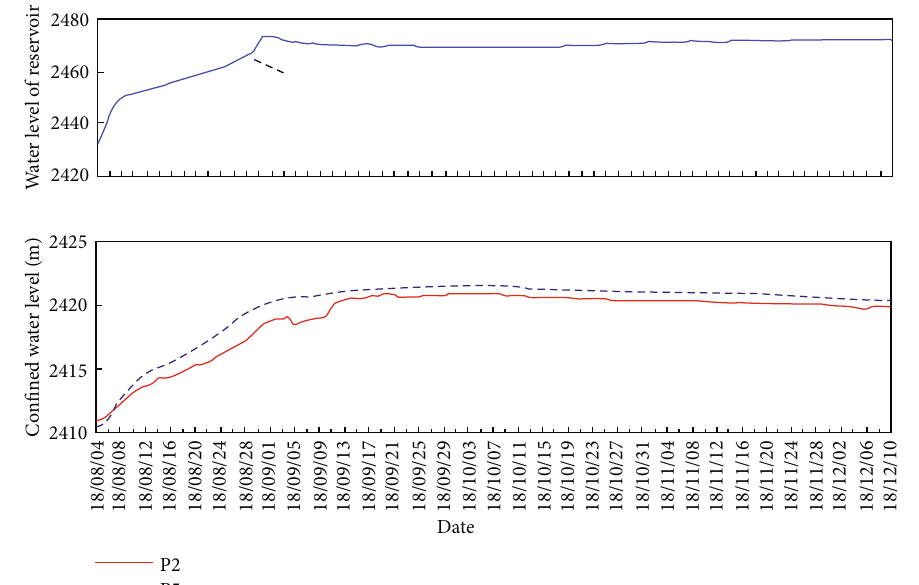
Figure 5: The monitoring reservoir water level and water level of seepage pressure at monitoring point P2 and P5 in the dam